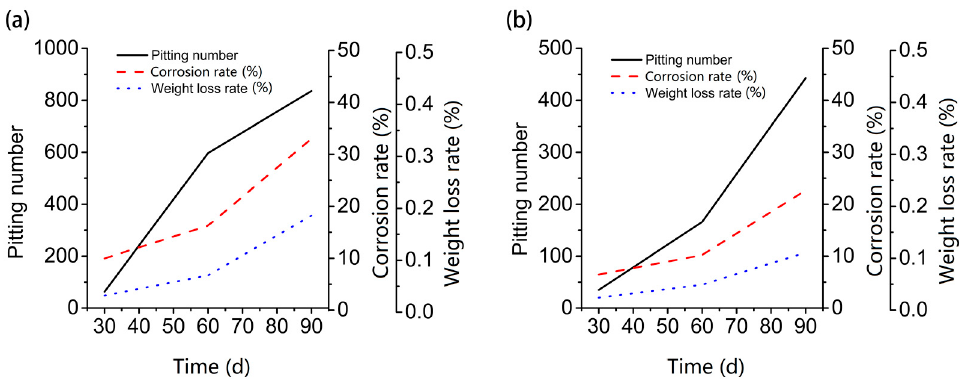
Figure 5. Comparison of the total number, corrosion rate, and weight loss rate; ( a ) contrast diagram of L1, ( b ) contrast diagram of L2.